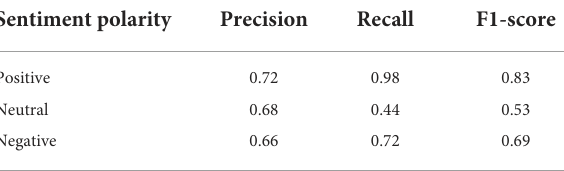
TABLE 1 Evaluation metrics of the pretrained model tested on our labeled